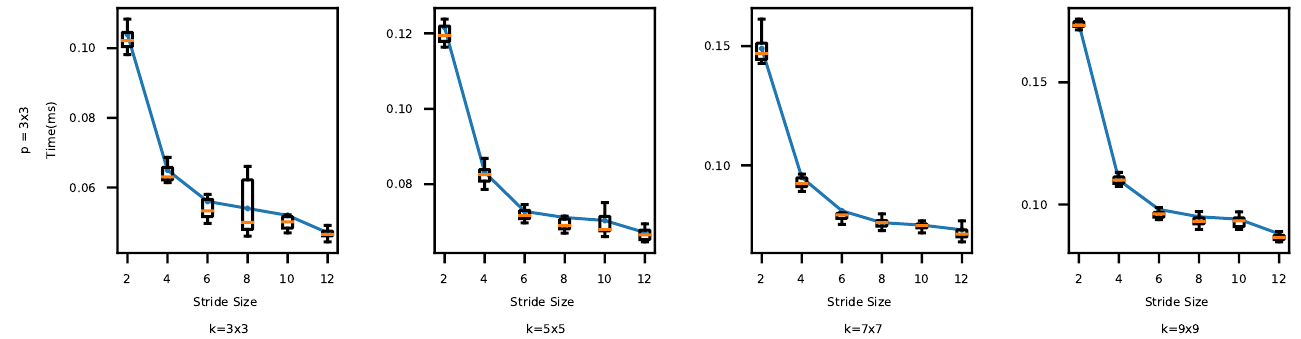
Figure 9. Stride Size vs. Execution Time (CIFAR-10). A bigger stride generally decreases the execution time, since data are processed in a more gross-grained manner.